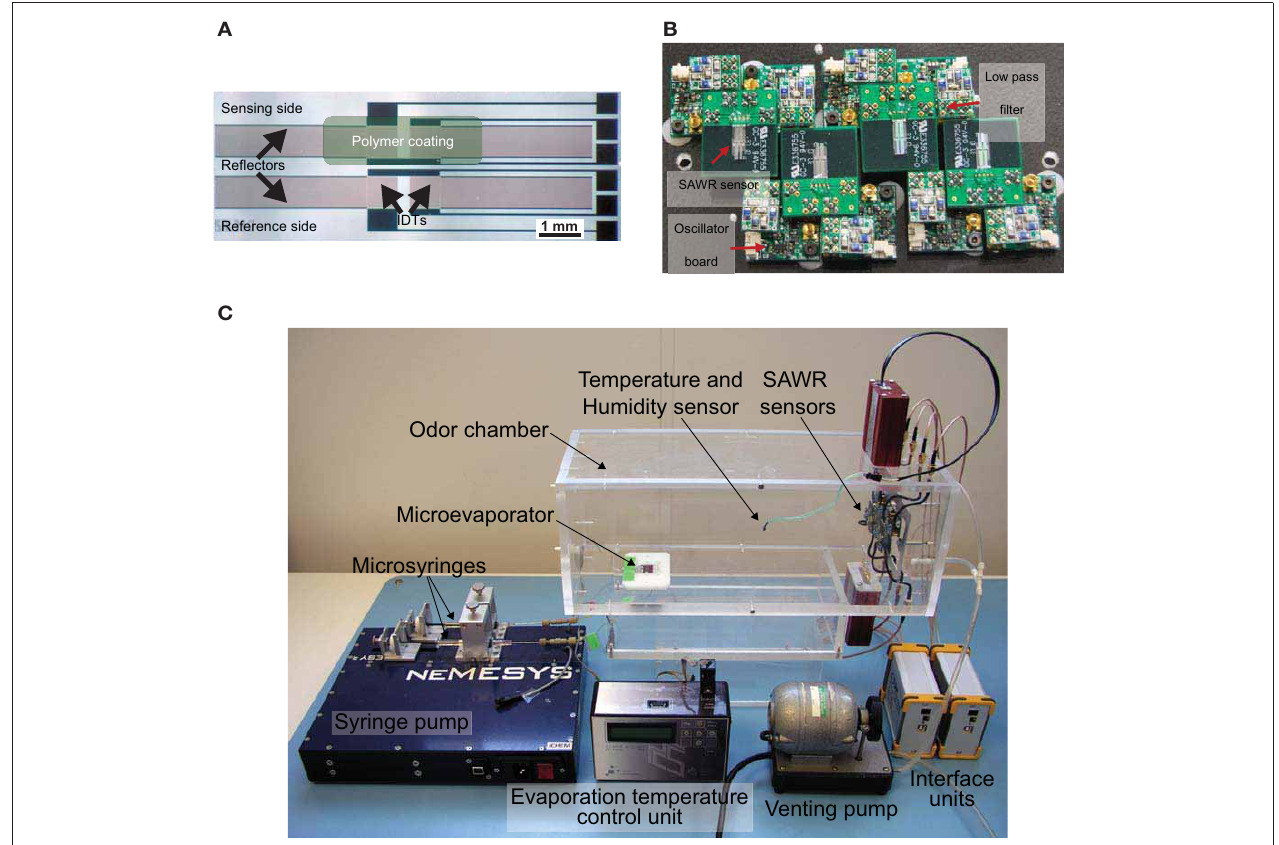
FIGURE 2 | (A) Optical micrograph of a 262MHz Rayleigh mode dual surface acoustic wave resonator (SAWR) chemosensor fabricated on X − propagating ST − cut quartz substrate with aluminium electrodes for air phase measurements. Each SAW resonator comprises a coated and non − coated reference device for drift and temperature compensation (see text). (B) Photograph of a 4-chemosensor SAW array together with the associated radio frequency oscillator and RF amplifier circuits to drive the acoustic